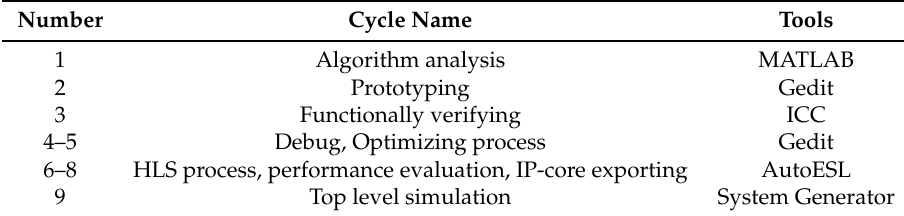
Table 1. Tool kits of the proposed design flow within Ubuntu.